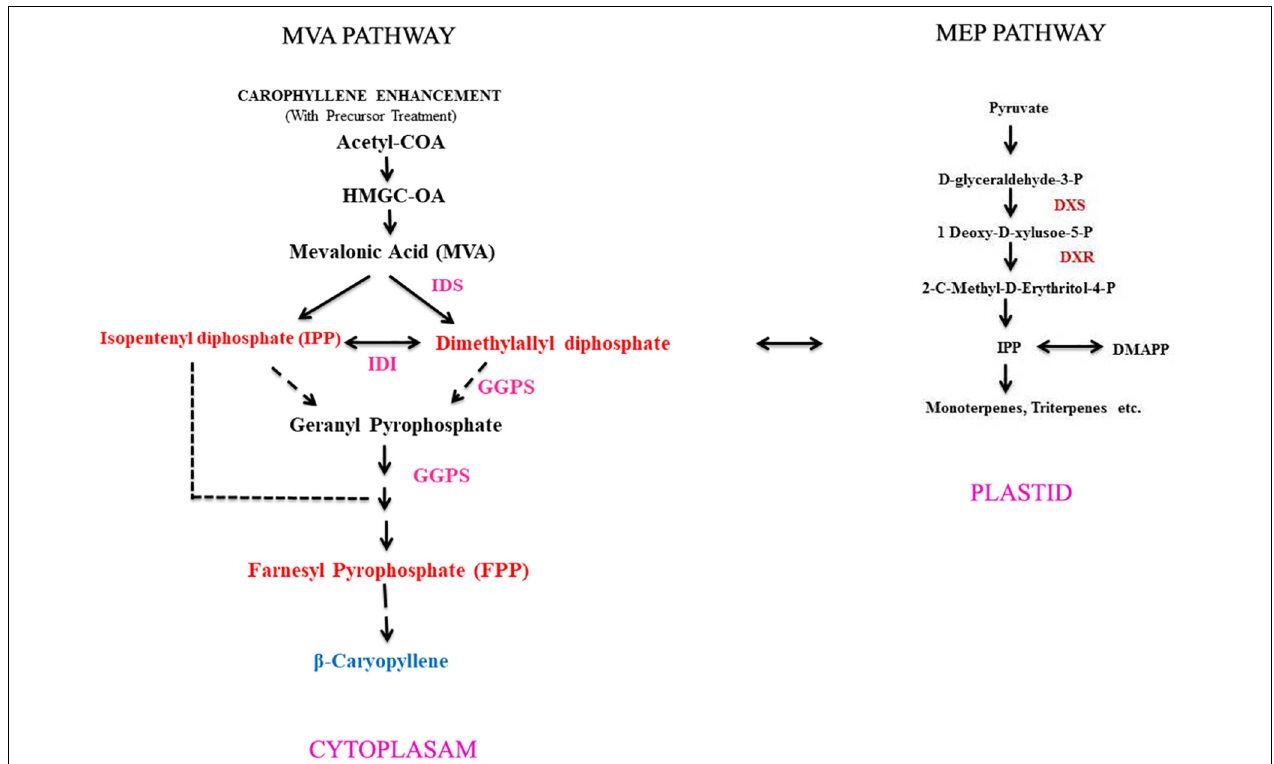
FIGURE 1 | An outline for β -caryophyllene compound biosynthesis pathway operating through in vitro method of A. vulgaris plant. IDS, isopentenyl diphosphate synthase; IDI, isopentenyl diphosphate isomerase; GGPP, geranylgeranyl diphosphate; DXS, 1-deoxy- D -xylulose-5-phosphate synthase; DXR, 1-deoxy- D -xylulose-5-phosphate